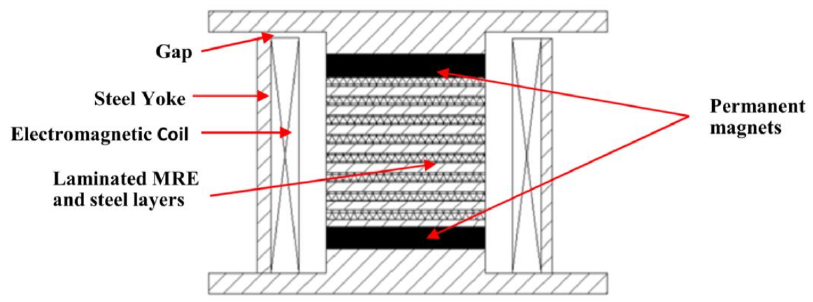
Figure 1. Magnetorheological elastomer (MRE) base isolator